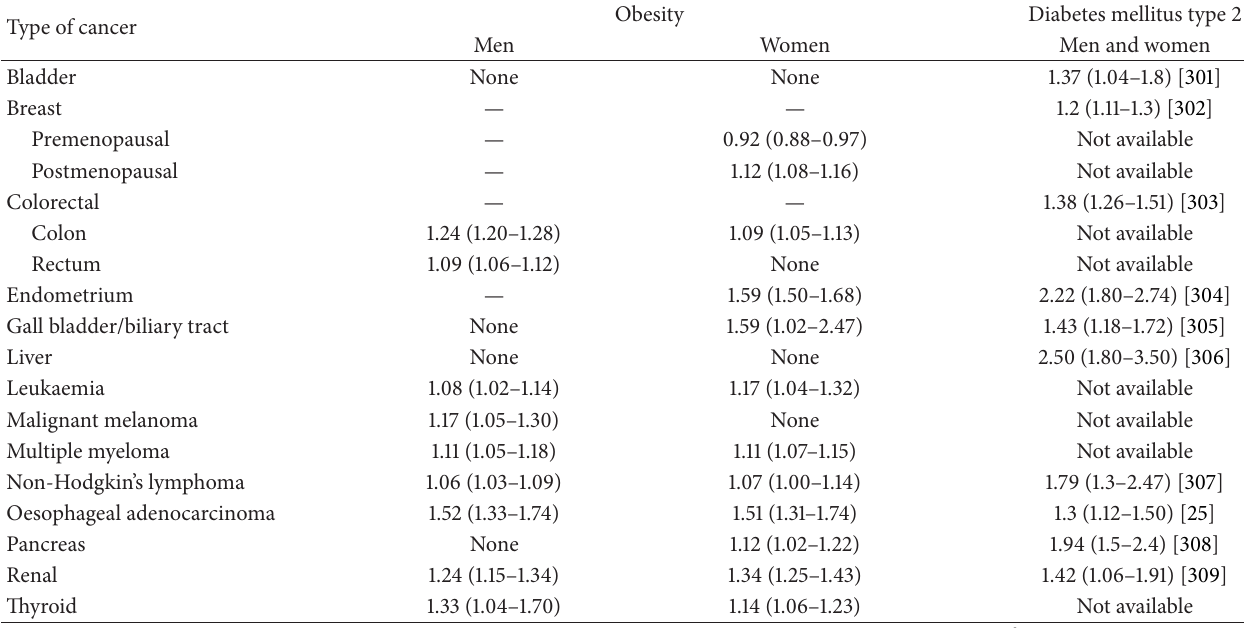
Table 2: Effects of obesity and diabetes mellitus type 2 on risk of different types of